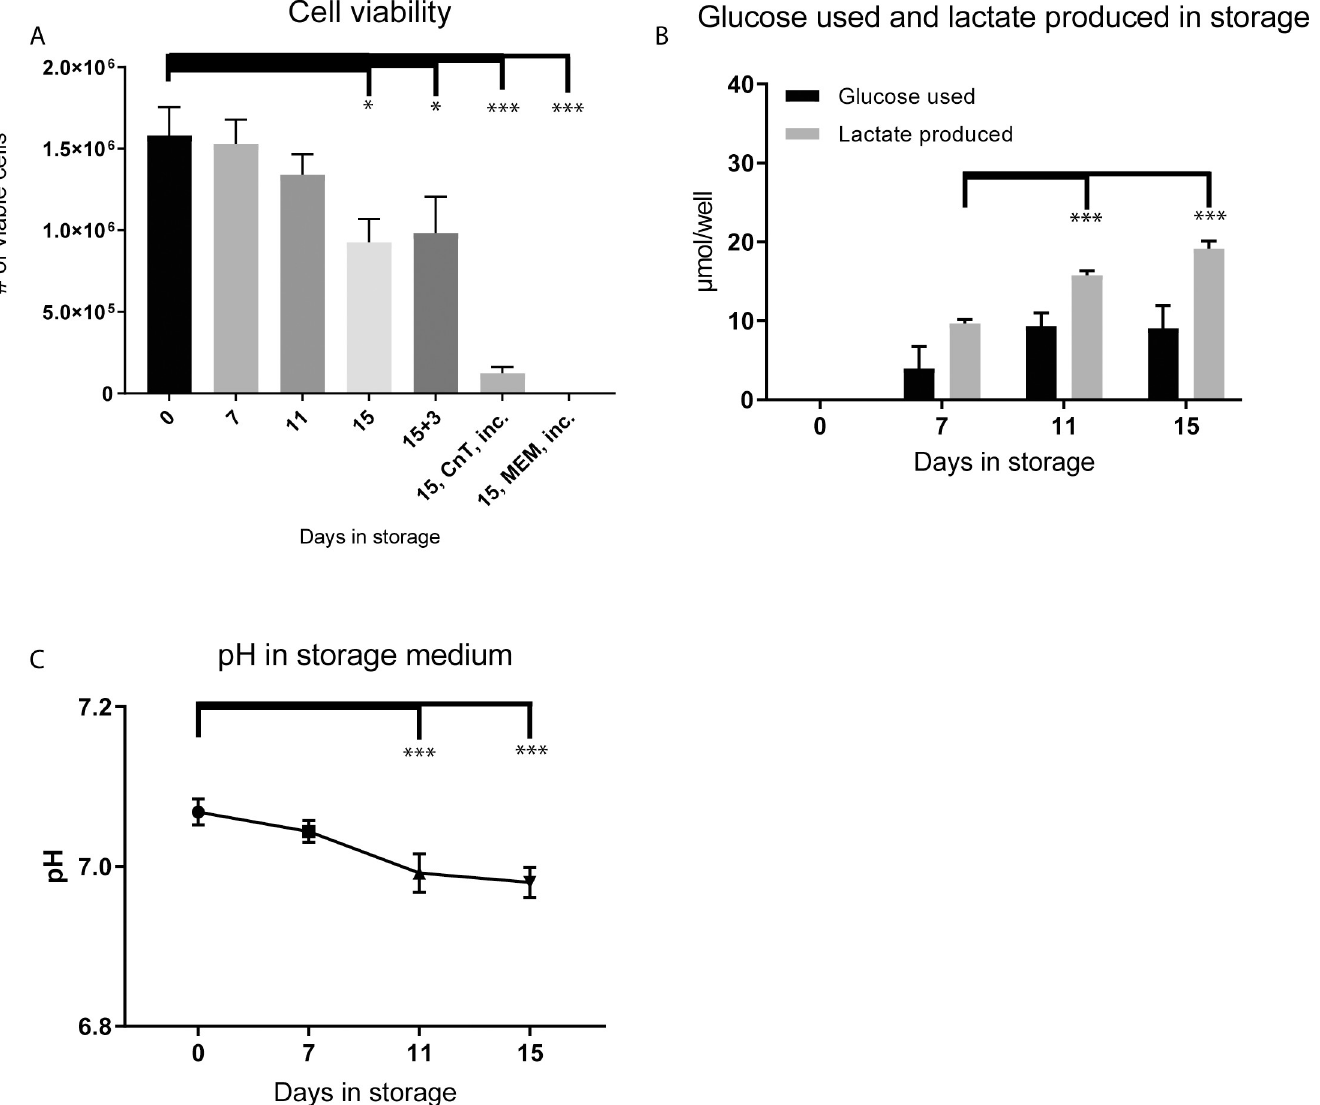
Fig 2. Cell viability and metabolic analyses during 15 days storage and 3 days re-incubation. (A) Cell viability showing counts of trypan blue negative cells. Viability significantly decreased between day 11 and 15 in storage. For comparison, cells left in a normal incubator (5% CO 2 , 37˚C) throughout the complete 15-day storage period in normal CnT-Prime or MEM storage medium resulted in poor cell survival (n = 6). ( B) The metabolites glucose and lactate were measured in the storage media before and after storage. The lactate produced was significantly increased at 11 and 15 days compared to 7 days. ( C) The pH of the storage medium was measured before and after storage. � = significant difference; p � 0.05; ��� = significant difference; p � 0.0001. https://doi.org/10.1371/journal.pone.0232270.g002 PLOS ONE | https://doi.org/10.1371/journal.pone.0232270 May 20,